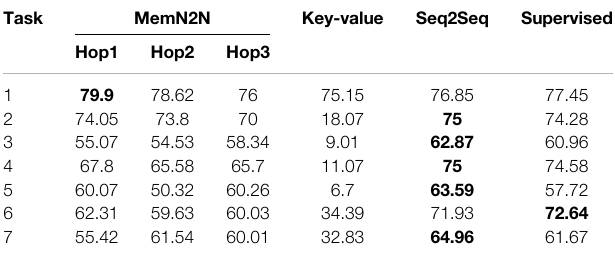
TABLE 6 | The out-of-vocabulary (OOV) set results of the Barista Dataset with 1,000 dialogues. The best performing methods (or methods within 0.1% of best performing) are given in bold for the per-response accuracy metric. The results show that on average and for task 7 (containing all tasks), Seq2Seq is the best performing model, similar to the test